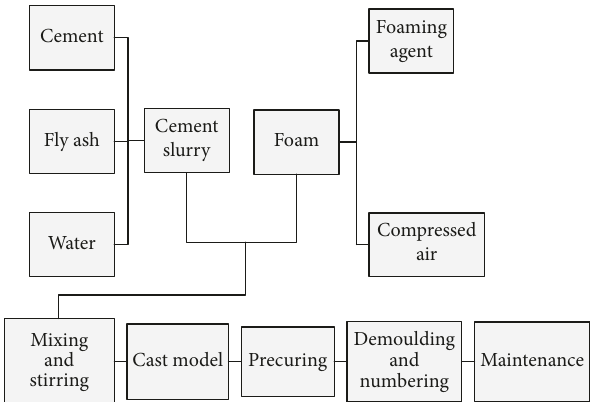
Figure 4: Preparation flowchart of